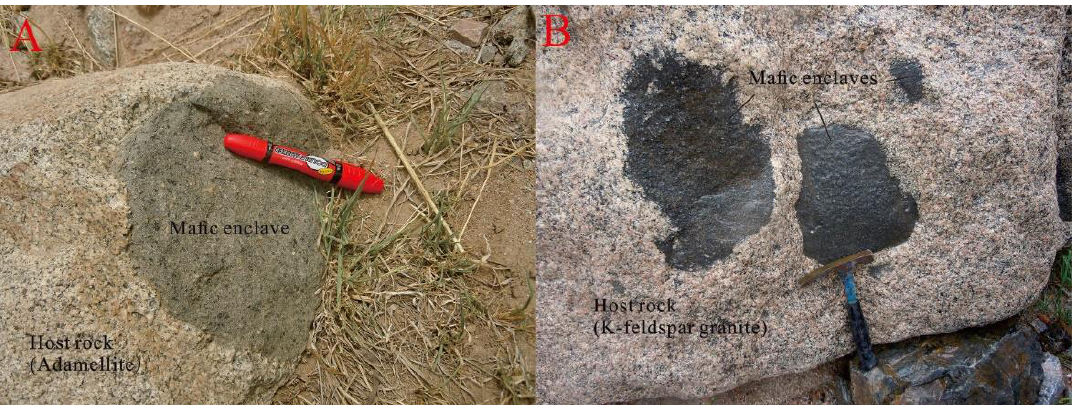
Figure 2. ( A,B ) Field occurrence of the mafic enclaves in the Qingshanbao complex of the Longshou Figure 2. Mountain.